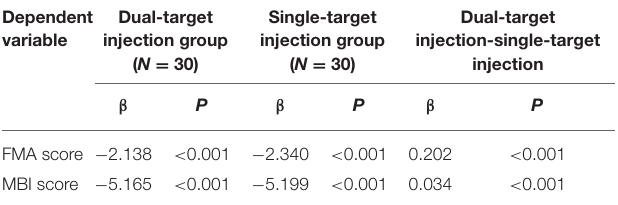
TABLE 3 | Linear mixed model analysis interaction of group *VAS score. Dependent